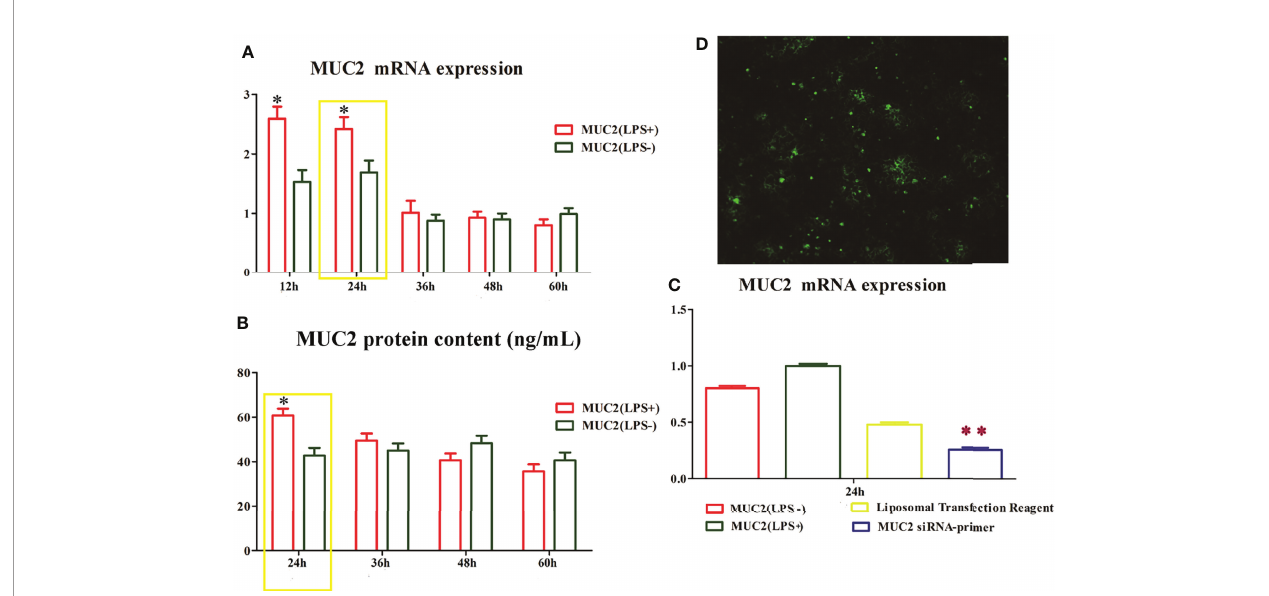
FIGURE 3 | The time and dose screen of small RNA interference. (A) , MUC2 mRNA expression in Caco-2/HT-29 co-culture cells after LPS stimulation for 12 h, 24 h, 36 h, 48 h, and 60 h; The highest level of MUC2 mRNA expression in Caco-2/HT-29 co-culture cells is observed at 24 h after LPS stimulation (N=6); (B) , MUC2 protein content in the supernatant of Caco-2/HT-29 co-culture cells after LPS stimulation for 24 h, 36 h, 48 h, and 60 h (N=6); the highest level of MUC2 protein content in Caco-2/HT-29 co-culture cells is observed at 24 h after LPS stimulation; * Statistical difference between co-culture Caco2/HT-29 cells in the LPS(+) compare to LPS(-) groups for the same time ( P <0.05); (C) , After LPS stimulation for 24 h, the Caco-2/HT-29 co-culture cells were transfected with 50 nM MUC2 siRNA or 50 nM negative control siRNA (siNC) using Liposomal Transfection Reagent. The MUC2 mRNA expression of MUC2 siRNA group was signi fi cantly decreased compare with that of the MUC2(LPS+) and MUC2(LPS-) groups (N=6); ** Statistical difference between co-culture Caco2/HT-29 cells in the MUC2 siRNA- primer compare to LPS(+) and LPS(-) groups ( P < 0.01); (D), Small interfering RNA transfection rate, the green point indicates positive signal of MUC2 small interfering RNA